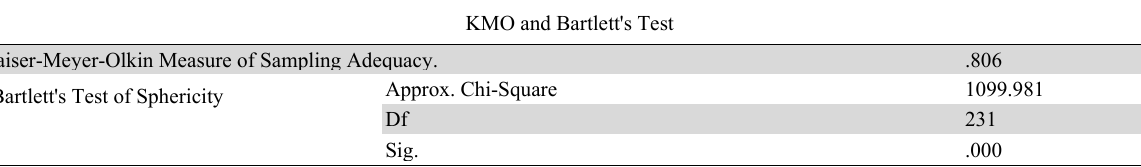
KMO and Bartlett's Test